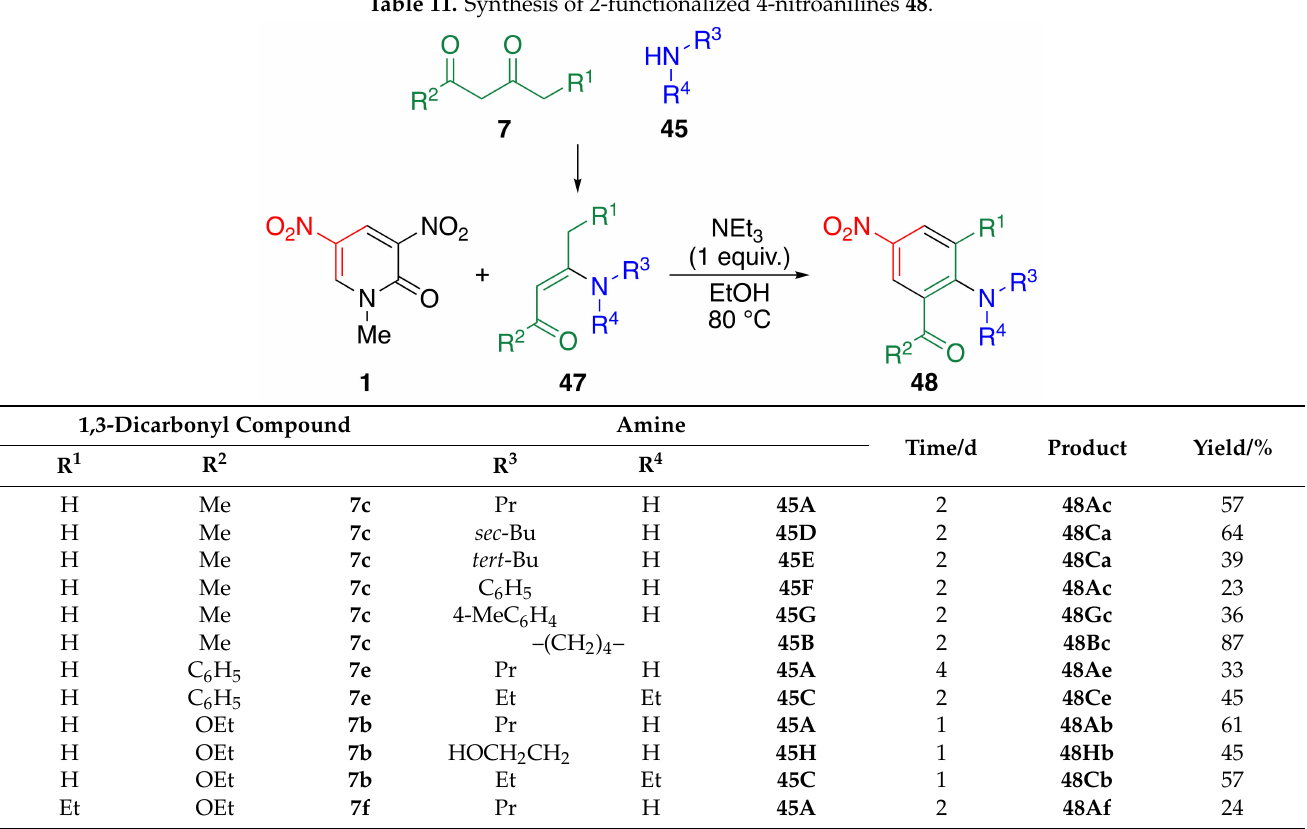
Table 11. Synthesis of 2-functionalized 4-nitroanilines 48